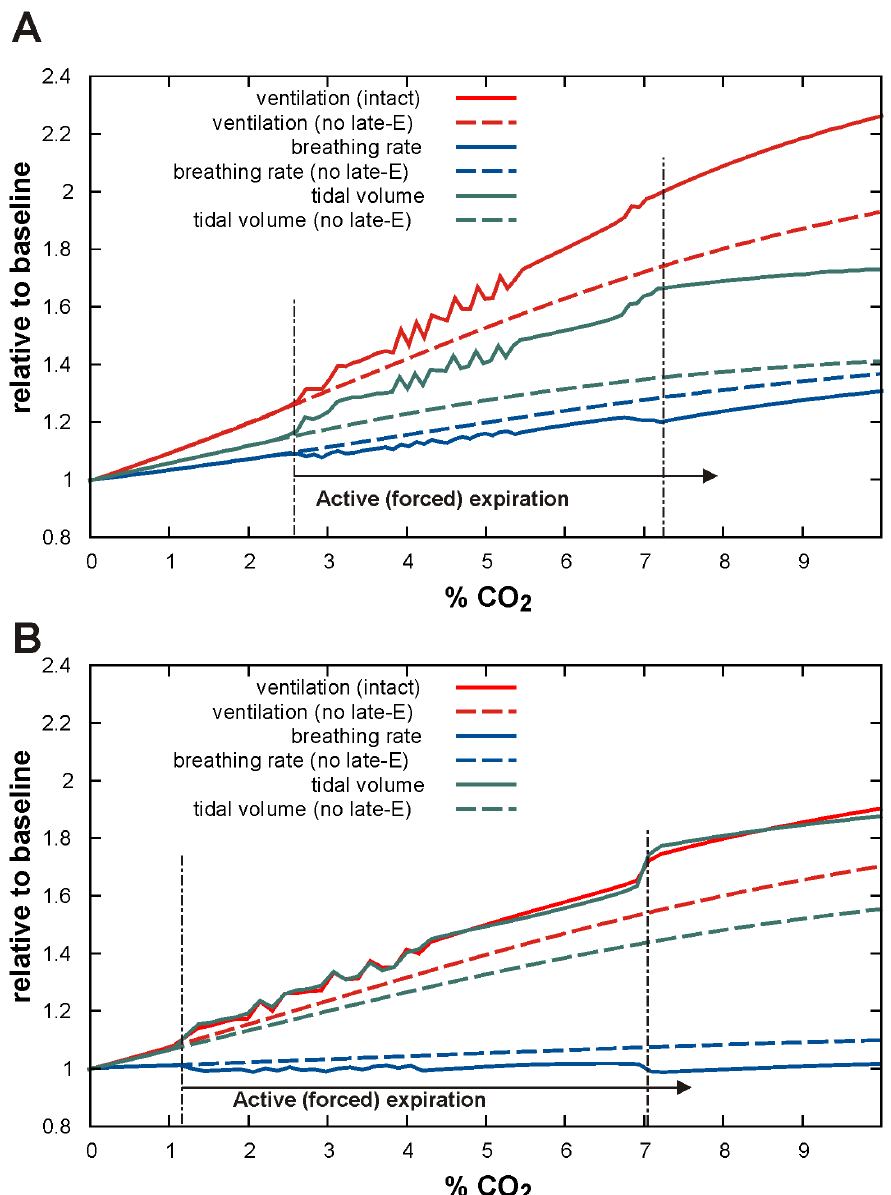
Figure 7. Changes in tidal volume, breathing rate, and ventilation (relative to normocapnia) with the development of hypercapnia in the intact (panel A) and vagotomized (panel B) models. CO2 content in the mouth f cm was linearly increased from zero to 10%. Changes in three major breathing characteristics (tidal volume, breathing rate, and ventilation) that would occur without active expiration (simulated by setting AbN=0) are shown by the corresponding dashed lines. The vertical dot-dashed lines bound the development (quantal acceleration) of active expiration. the brainstem respiratory network and CPG, representing the neural controller, and the biomechanical model of lungs including gas exchange and transport mechanisms, representing the controlled subsystem and providing both mechanical and chemical feedback to the neural controller. Previous models of this system did not consider all of these components together. For example, Rybak et al. [12] and later Molkov et al. [18] coupled a detailed